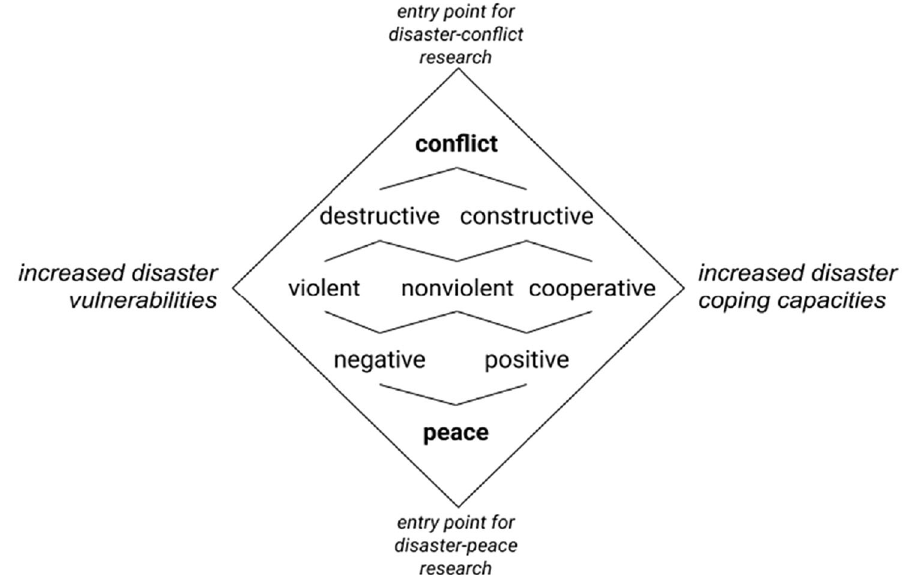
Fig. 1 A conceptual model